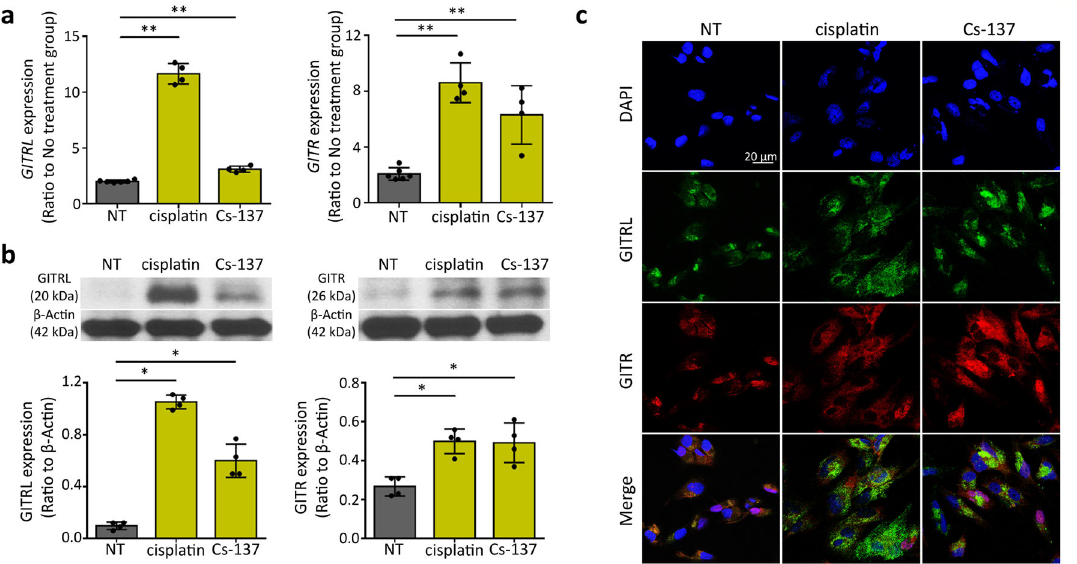
Fig. 2 Expression of GITRL and GITR in sarcomatoid mesothelioma cell line (CRL5946) increased when treated with cisplatin or Cs-137 irradiation. CRL5946 cells were exposed to cisplatin 2 μ g/ml for 24 h or Cs-137 irradiation 7.5 Gy then collected 4 days later. a qPCR shows that GITRL and GITR mRNA expressions are signi fi cantly increased in cisplatin-treated and Cs-137-irradiated cells. b Representative histograms show GITRL and GLTR protein expressions are increased in cisplatin-treated and Cs-137-irradiated cells. c Immuno fl uorescence staining for GITRL (green), GITR (red), DAPI (blue) in CRL5946 treated with cisplatin or Cs-137 irradiation. DAPI was used as a nuclear marker. * P < 0.05; ** P < 0.01; vs nontreated control, determined by using Mann – Whitney U